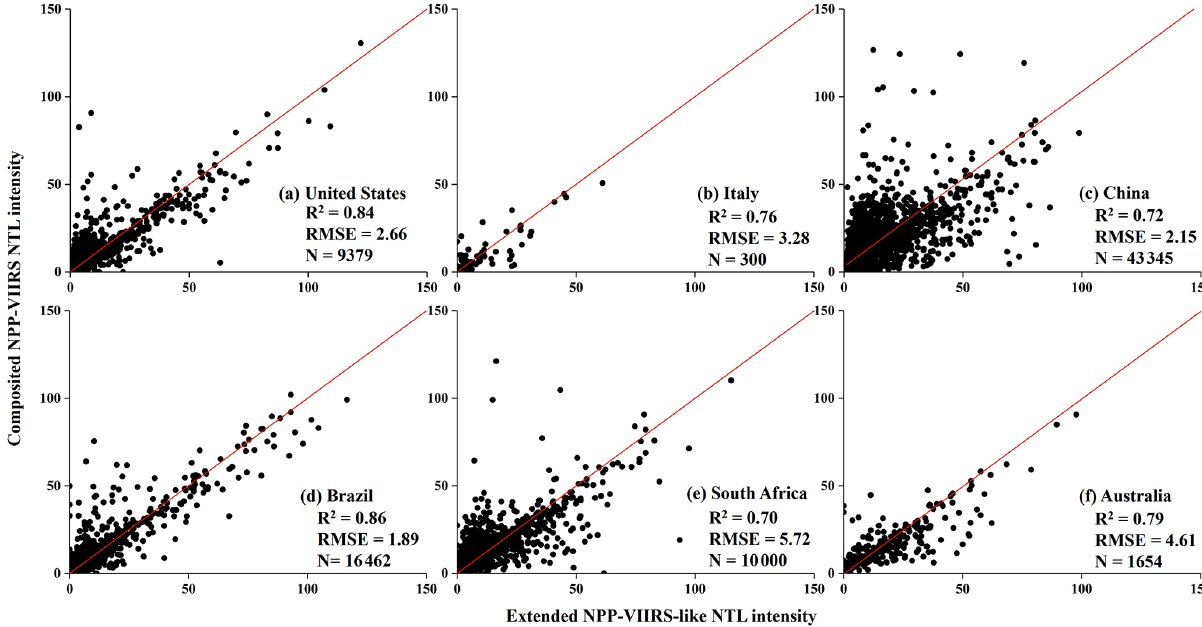
Figure 6. The comparison between composited NPP-VIIRS NTL data and extended NPP-VIIRS-like NTL data in 2012 (unit: nWcm − 2 sr − 1 ) at the pixel level in six countries. The solid line denotes the 1 : 1 line, and N is the number of sample points (cities).